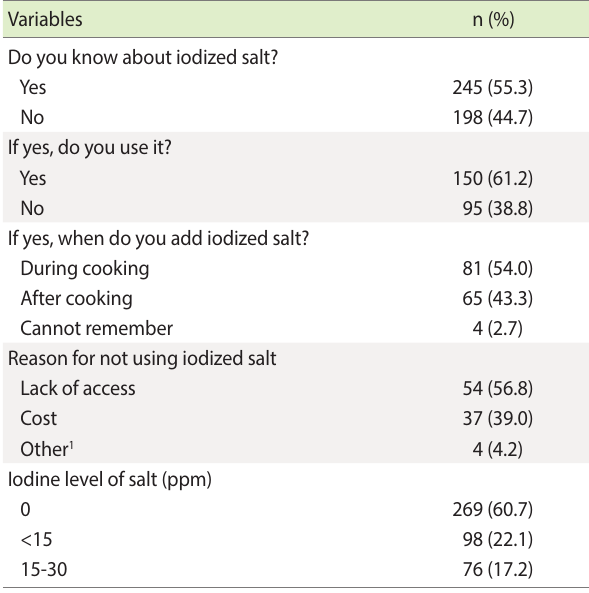
Table 3. Knowledge and utilization of iodized salt by mothers in Gasgibla woreda , Waghimra Zone, northeast Ethiopia,